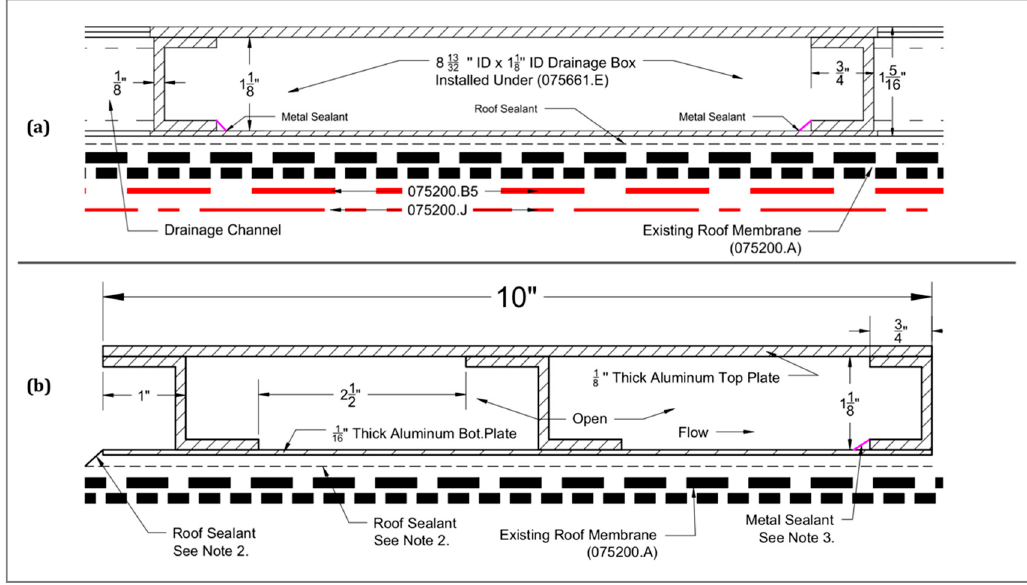
Figure 2. ( a ) Cross section of longitudinal section. ( b ) Cross section of transverse section.